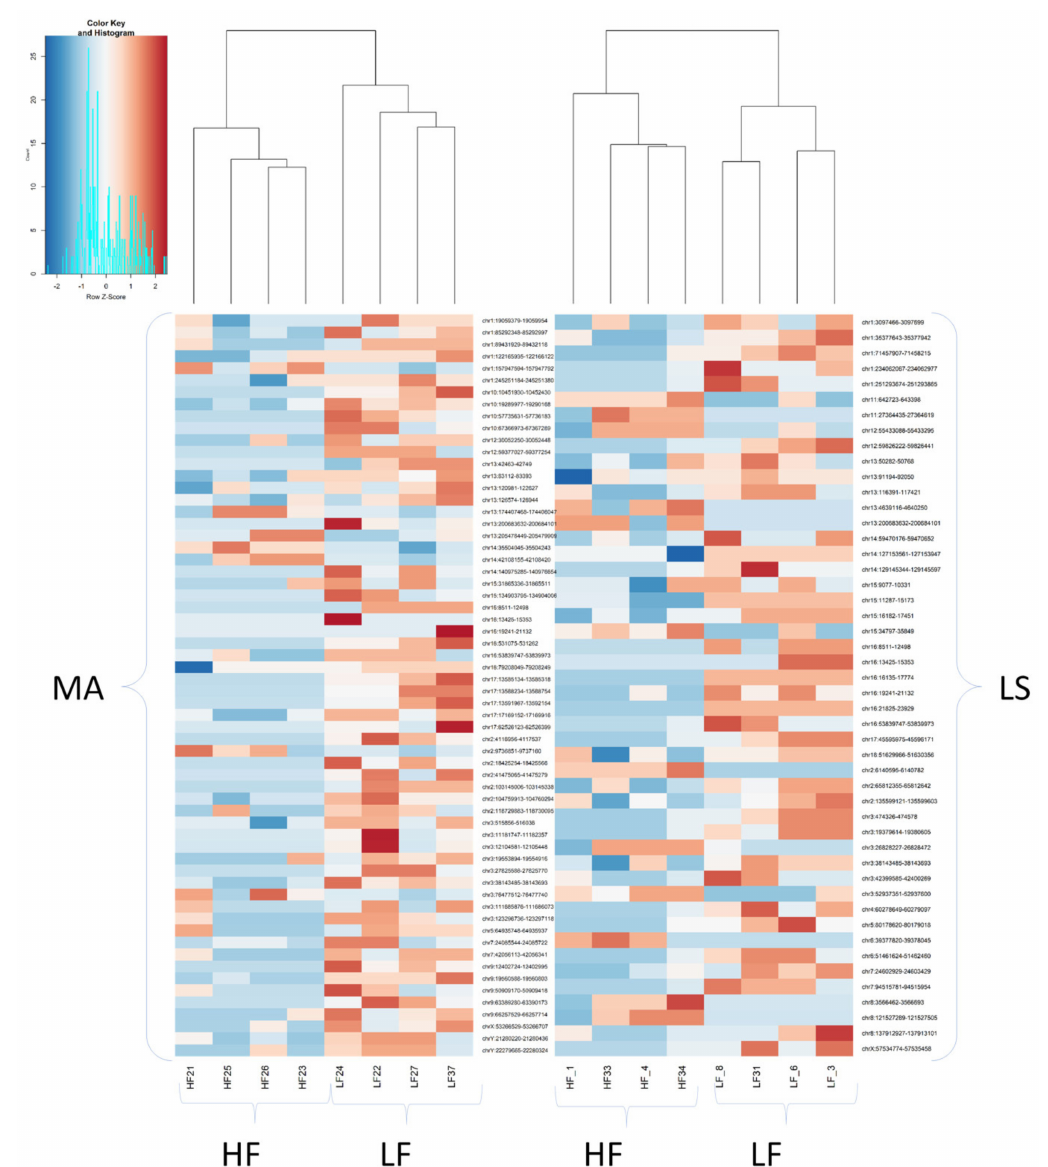
Figure 3. Heatmap across 39 samples from boars ranked as high fertile (HF, n = 15) or low fertile (LF, n = 11). LS = late-summer, MA =